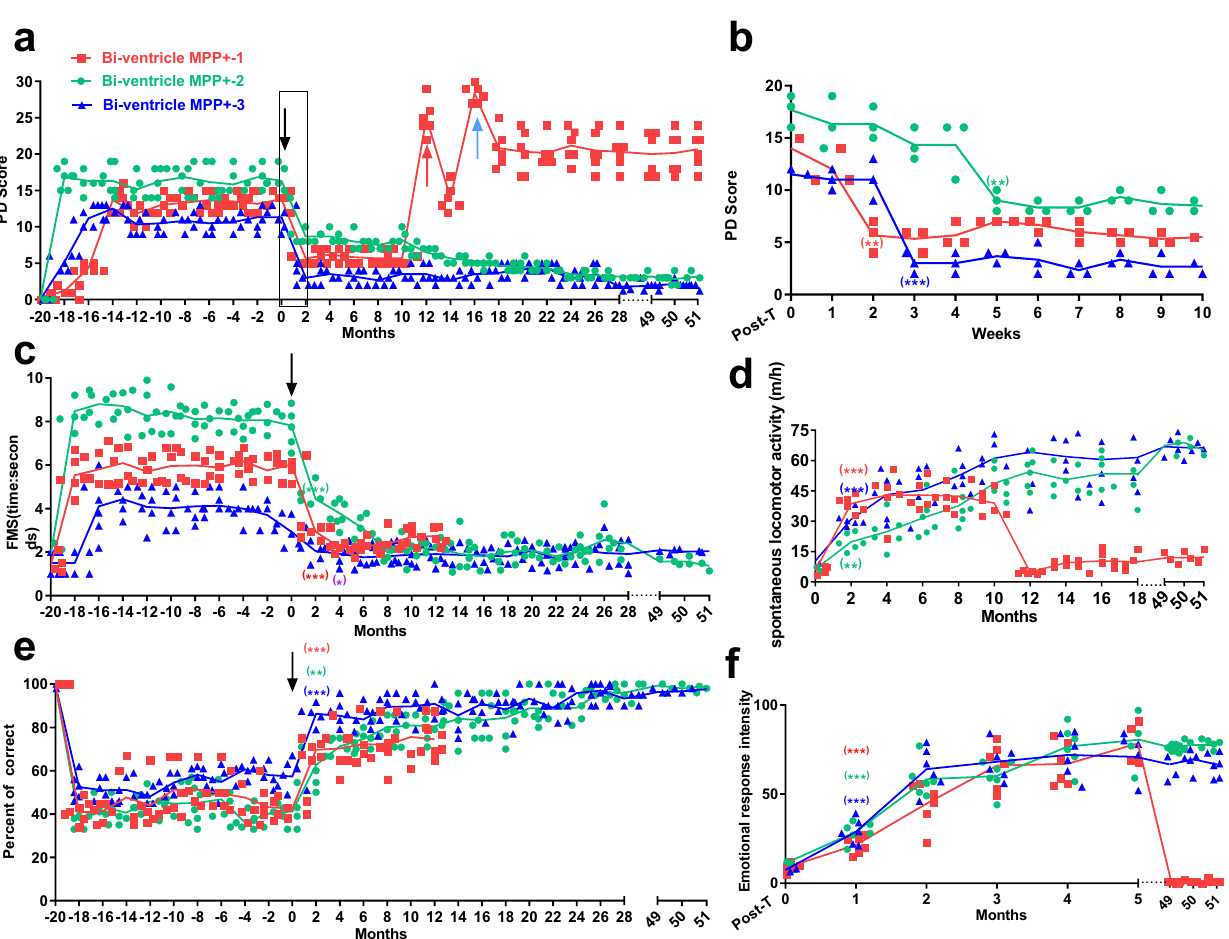
Fig. 4 DOPA-MSC grafts rescued the behaviors of bilateral chronic PD monkeys induced by lateral ventricle administration of MPP + . a and b Changes in PD scores of chronic PD monkeys receiving DOPA-MSCs ( n = 3) from 20 months before transplantation to 51 months after transplantation. Each value is from the average result of 6 blind evaluations. The red and blue arrows indicate the second transplantation and intravenous injection of DOPA-MSCs for the Bi-ventricle MPP + -1 monkey, respectively. b Changes in monkey PD scores during the indicated times for the indicated times in the red box in panel ( a ). c FMS showing changes in single grasping time in PD monkeys ( n = 3) before and after receiving DOPA-MSCs. Each value is based on the average of 4 experiments before transplantation and of 6 experiments posttransplantation. d Primate SCAN showing changes in spontaneous locomotor activity after DOPA-MSC transplantation. Each value is from the average result of 6 tests per month. e The working memory tests showing the correct rate of PD monkeys before and after DOPA-MSC transplantation. Each value is from the average result of 6 tests. f Emotional response assays showing the improvement of emotional responses in PD monkeys after transplantation. Each value is from the average result of six tests. Two-tailed Student ’ s t -test was performed by self-comparisons of the monkeys before and after tests; * p < 0.05; ** p < 0.01; *** p <